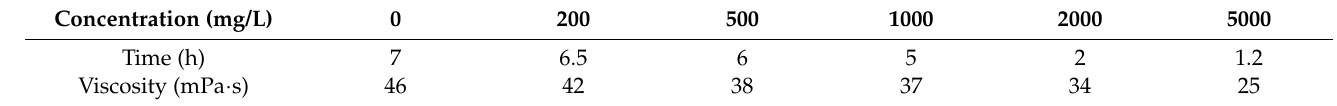
Table 4. Effects of different amounts of B3 on the solubility of the polymer.